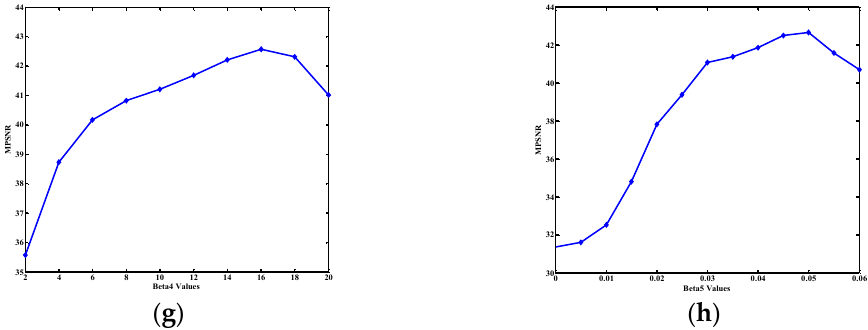
Figure 13. The MPSNR curves as function of the regularization parameters. The relationship between MPSNR and the parameters ( a ) λ ; ( b ) γ ; ( c ) α ; ( d ) β 1 ; ( e ) β 2 ; ( f ) β 3 ; ( g ) β 4 ; ( h ) β 5 .